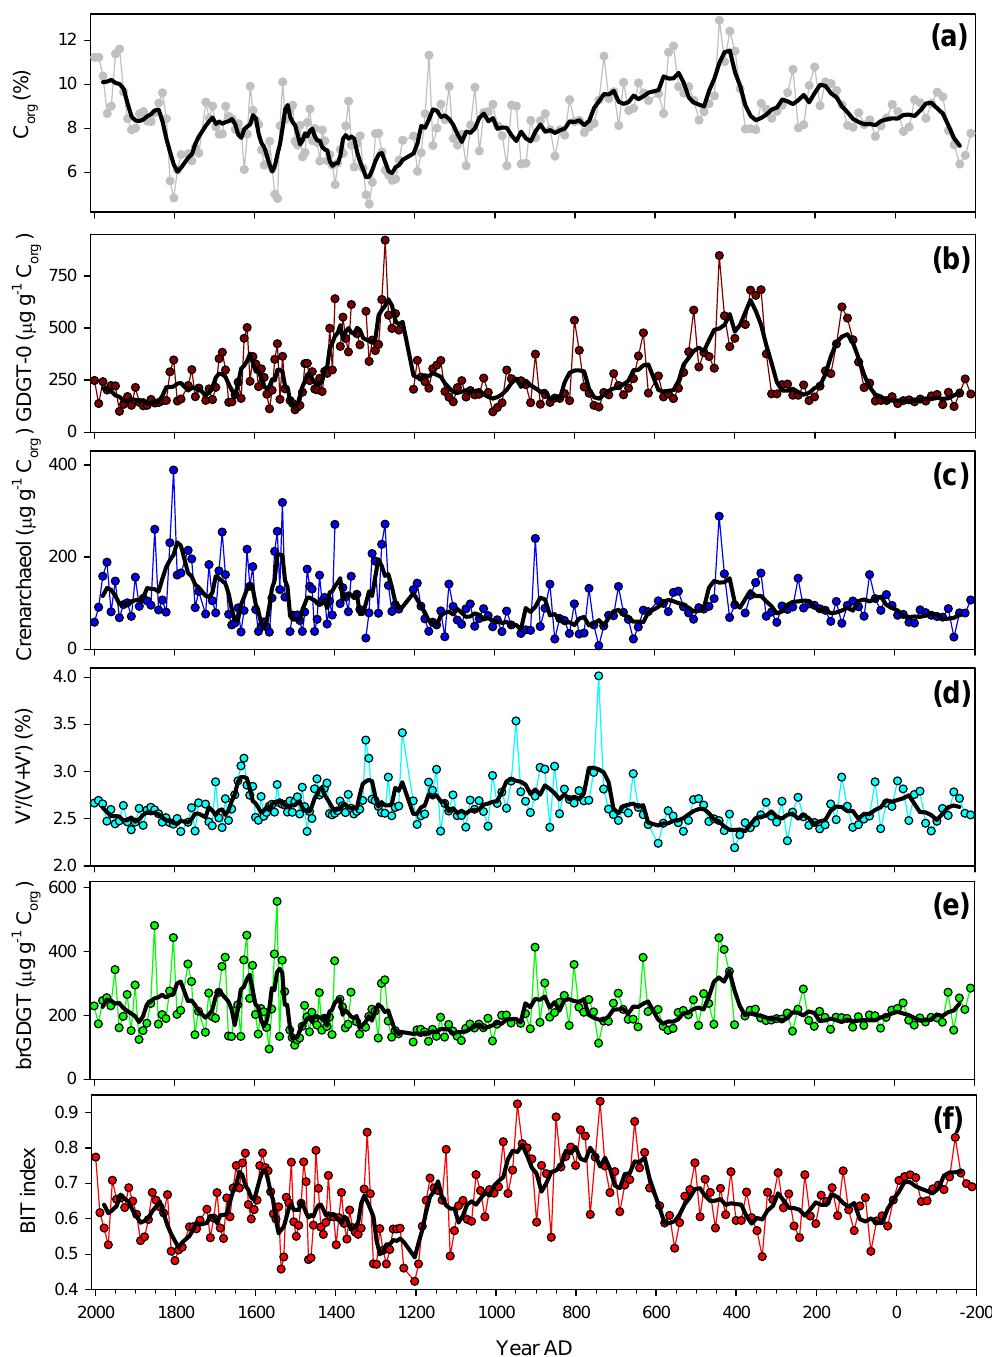
Figure 2. Bulk and GDGT parameters in the 213cm long composite sediment sequence from Lake Challa compared with sediment age in years AD. (a) C org , (b) GDGT-0 concentration, (c) crenarchaeol (GDGT-V) concentration, (d) the percentage of crenarchaeol regioisomer concentration relative to crenarchaeol, (e) summed brGDGT concentration, and (f) BIT index. Points connected by a thin line represent raw data and the thicker black lines denote 5-point running averages. A few data points are missing for GDGT concentrations because these were not quantitatively